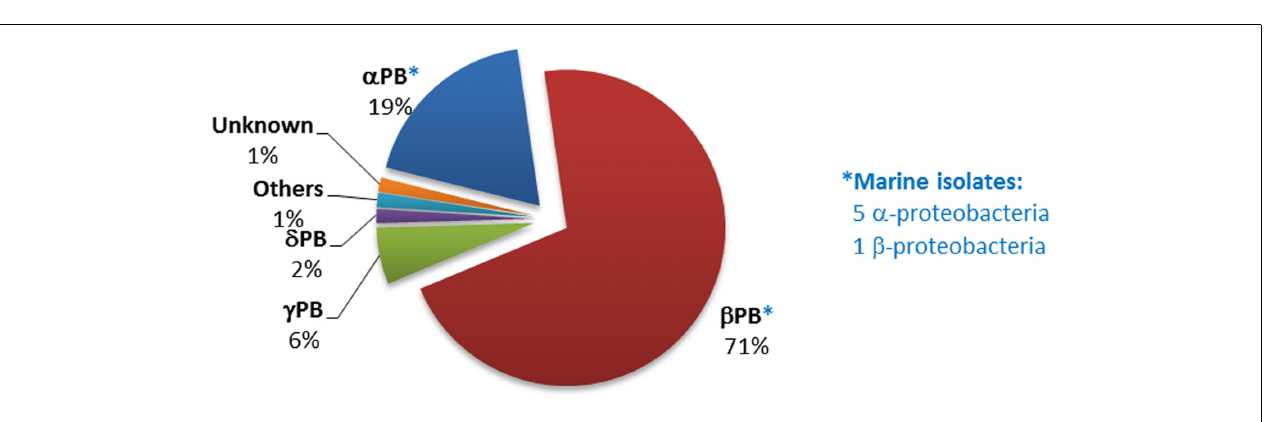
the phnA gene, out of the 190 sequenced marine bacterial genomes publically available, are indicated to the right of the Figure.